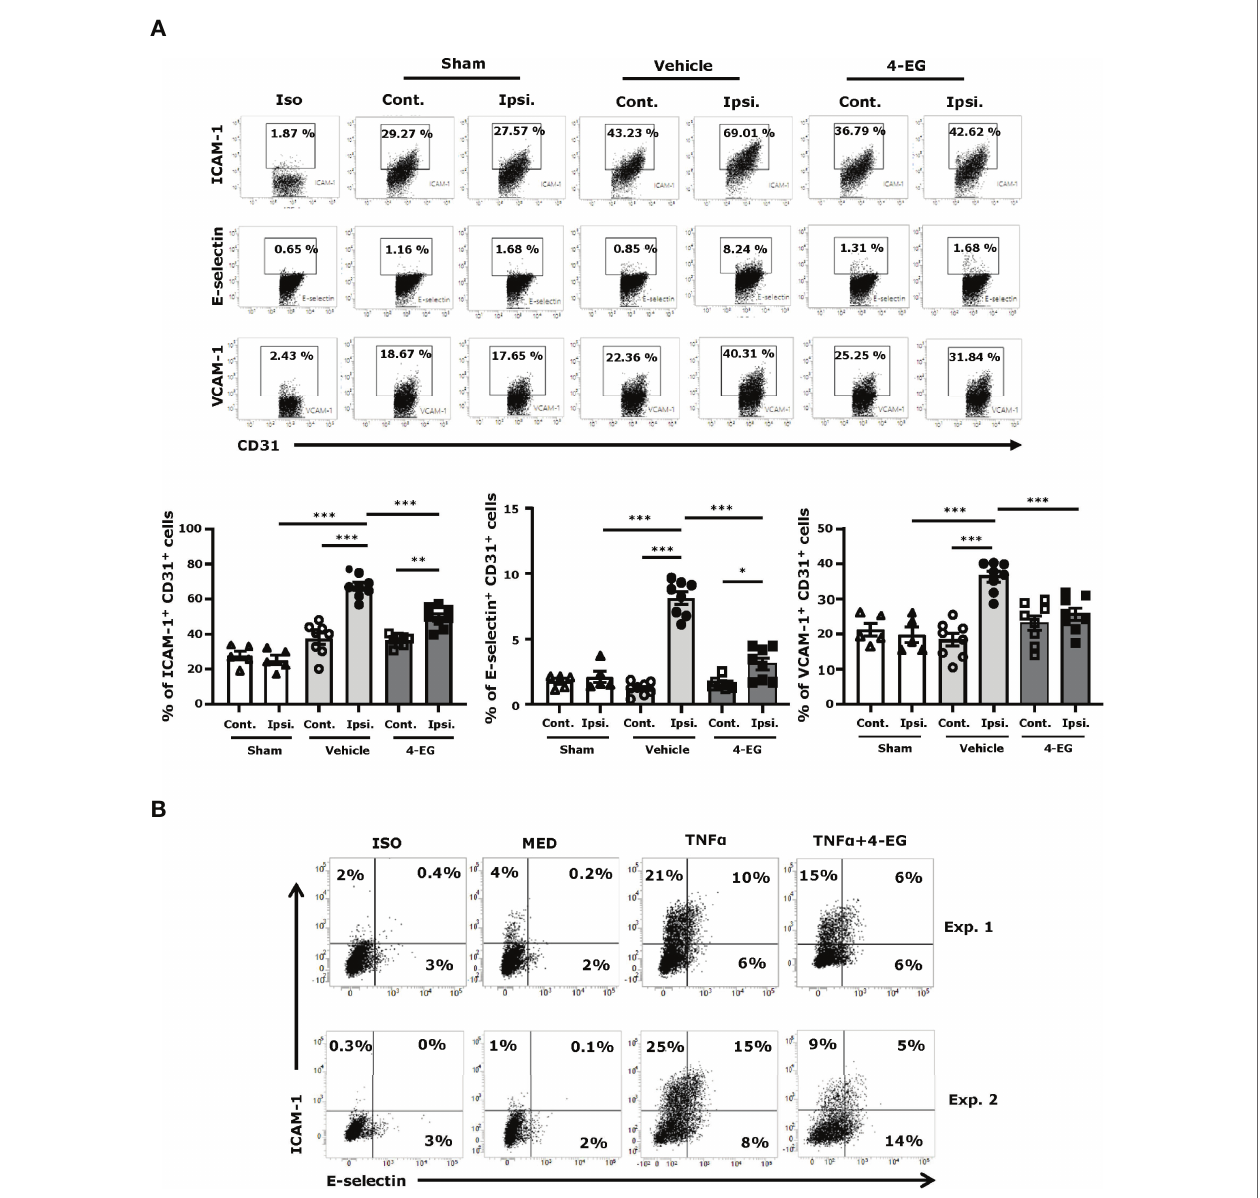
FIGURE 4 | 4-EG inhibits brain endothelial adhesion molecule expression in the ischemic brain. (A) C57BL/6 male mice were subjected to sham or 40 min MCAO followed by the i.v. administration of vehicle or 4-EG (100 mg/kg) at 2 h post-reperfusion. At 16 – 20 h post-injury, the contralateral and ipsilateral hemispheres of sham (n=5), and vehicle- and 4-EG- treated MCAO mice (n=8/group) were harvested and subjected to microvasculature isolation. The isolated cells were then stained with CD31 in the combination with ICAM-1, E-selectin, or VCAM-1 followed by fl ow cytometry analysis. Isotype controls (Iso) were used as a negative control to determine CD31 + brain endothelial cells positive for ICAM-1, E-selectin, or VCAM-1 expression. The frequency of ICAM-1 + , E-selectin + , and VCAM-1 + CD31 + cells was determined. * p<0.05 , **p < 0.01, *** p < 0.001 by two-way ANOVA. (B) bEnd.3 cells were pretreated with 4-EG 200 µM for 1 h followed by TNF a 50 ng/ml stimulation for 4 h. Cells were then harvested and stained with ICAM-1 and E-selectin followed by fl ow cytometry analysis. Two representative fl ow cytometry results of fi ve independent experiments are